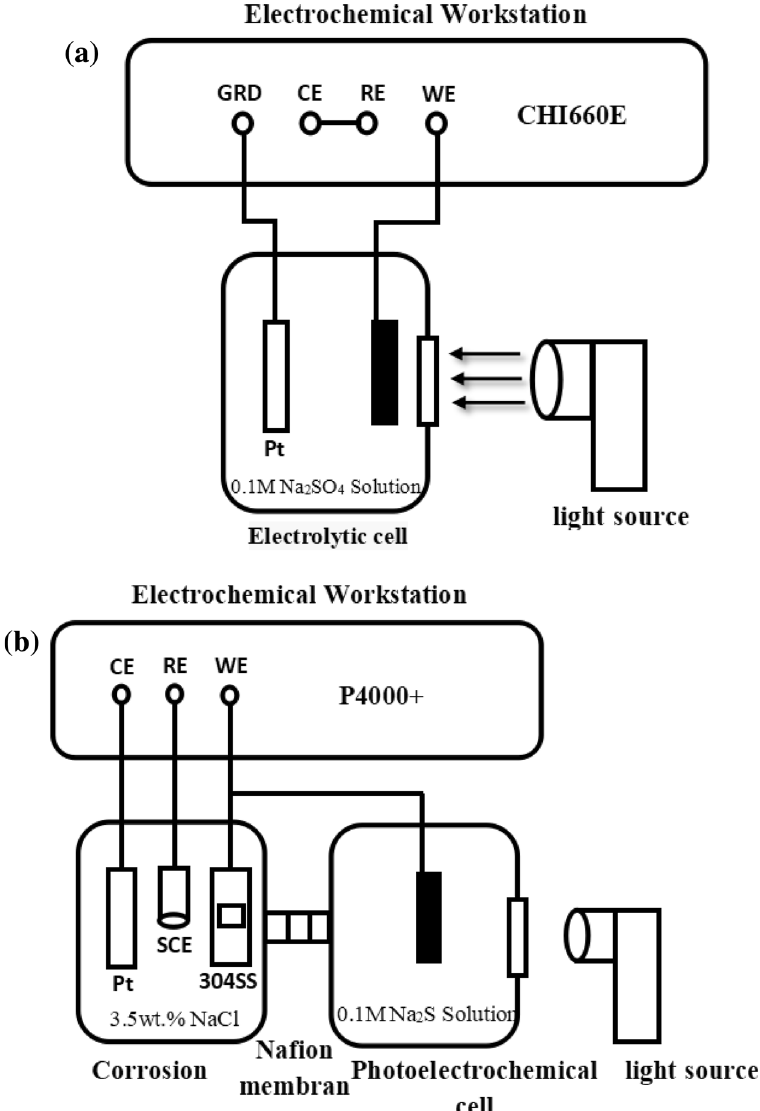
Figure 1. ( a ) Photocurrent density measurement setup, ( b ) Experiment setup for electrochemical